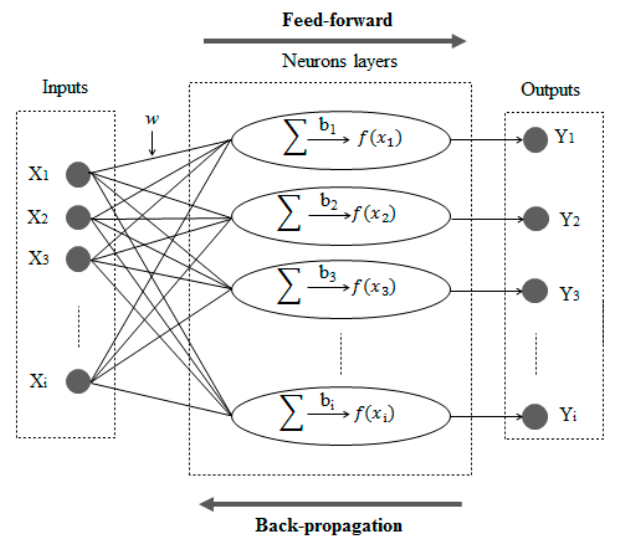
Figure 1. Architecture of an artificial neural network (ANN) and feed-forward back-propagation algorithm.